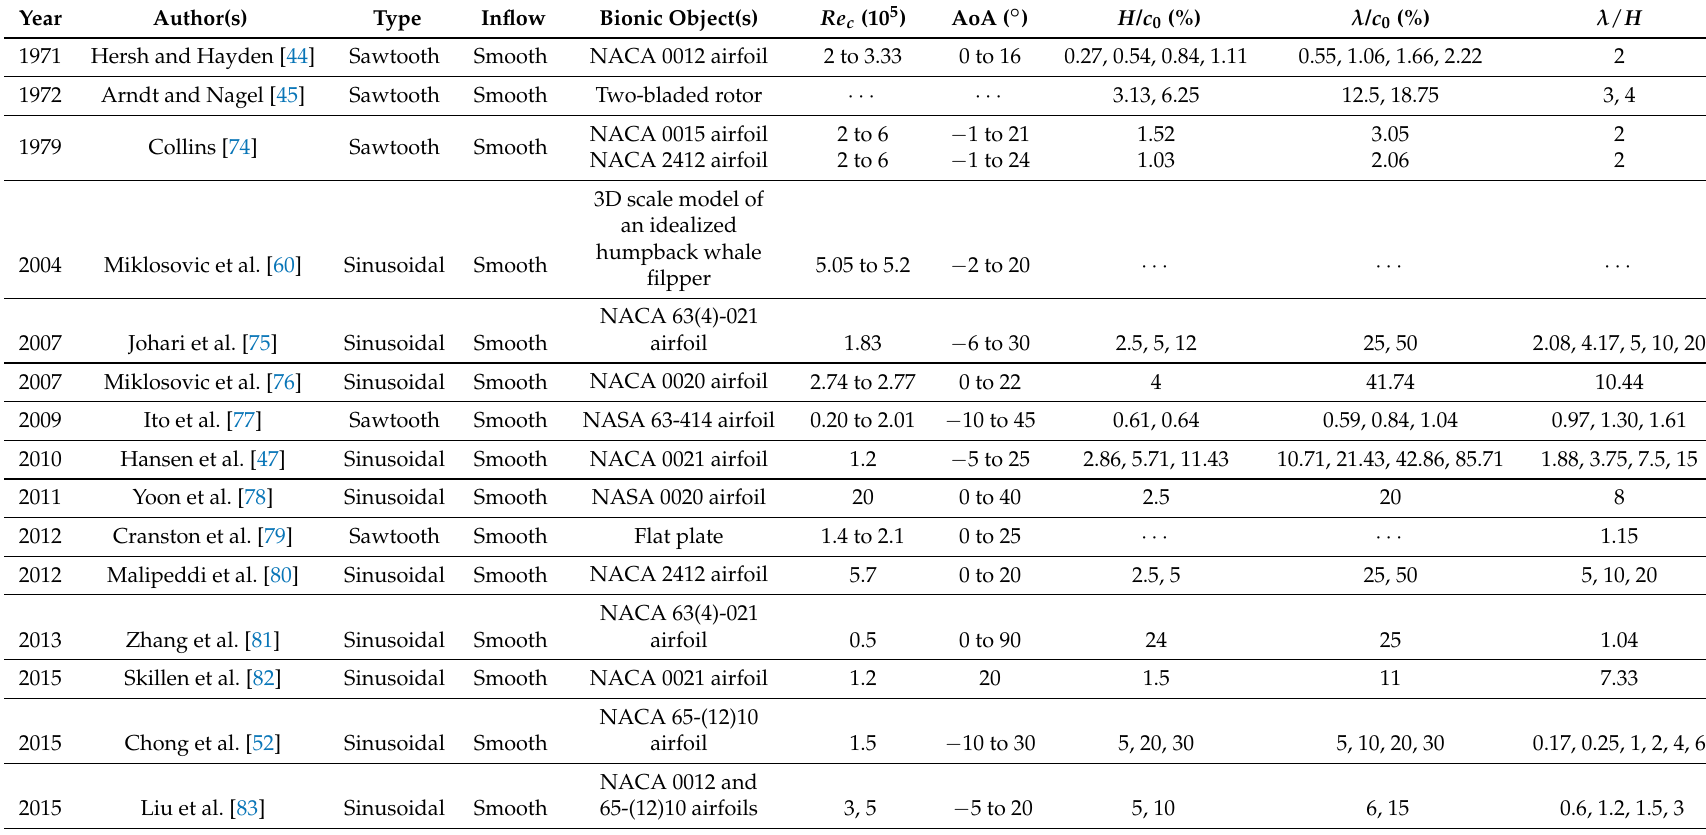
Table 4. Selected investigations of aerodynamic effect of leading edge serrations (“ · · · ” denotes “not